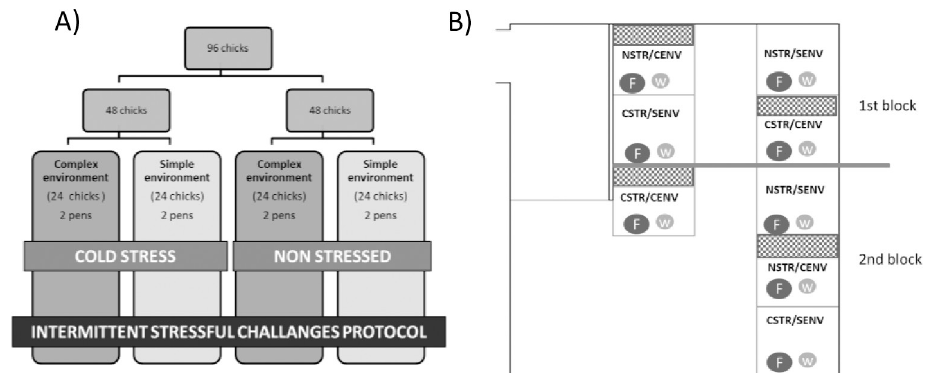
Fig 2. Experiment description. (A) Experimental design : for this experiment 96 domestic fowl chicks ( Bovan robust , a white laying strain) were randomly assigned to either a Complex or a Simple home environment (CENV, SENV respectively; N = 48 per treatment). Additionally, birds from each environment were allocated to either a Cold Stress (CSTR) or No Stress (NSTR) treatment. At four weeks of age birds with different early life experiences (CSTR-CENV, CSTR-SENV, NSTR-CENV, NSTR-SENV, two pens/treatment, eight pens in total) were exposed to an Intermittent Stressful Challenges Protocol (ISCP); (B) Distribution of the treatments across the experimental room : each square division represents a pen, F indicates the feeder, W the drinker, CENV refers to Complex Environment, SENV to Simple Environment; NSTR refers to a No Stress group while CSTR refers to a Cold Stress group.